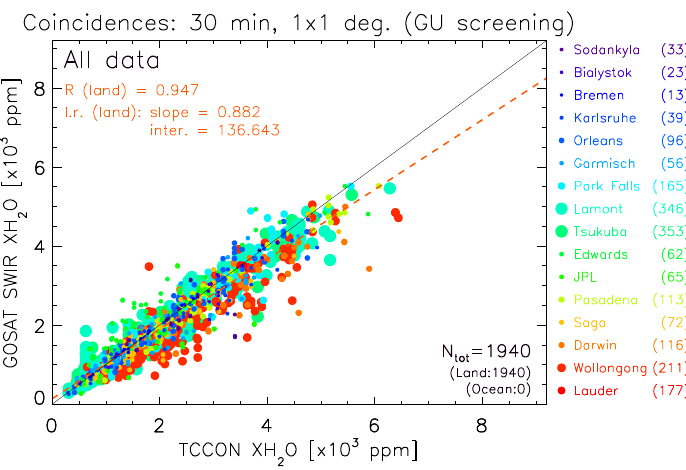
Figure 4. Scatter plot of the GOSAT TANSO-FTS XH 2 O and coincident TCCON soundings (criteria of ± 30min and ± 1 ◦ in latitude/longitude). For these criteria, there are no coincident TANSO-FTS ocean scans. The caption and color-coding are identical to those of Figure 3.